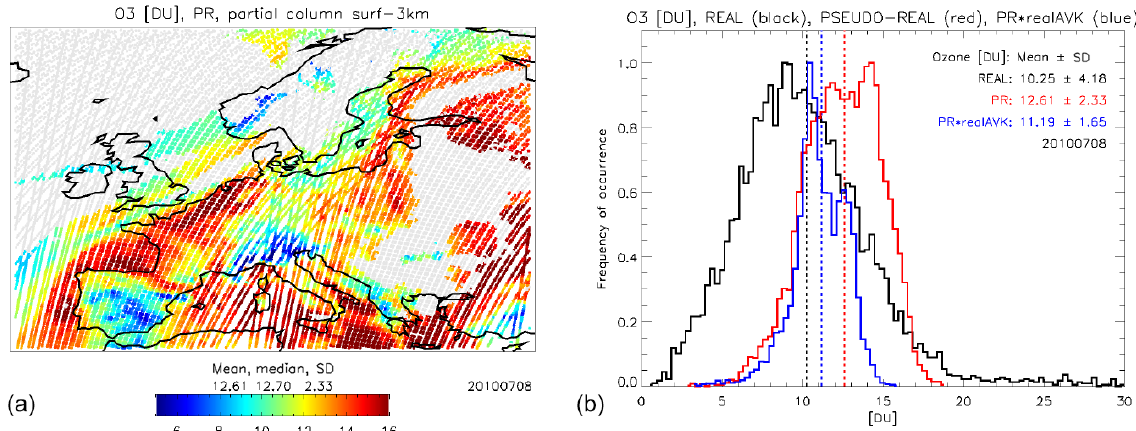
Figure 2. MOCAGE simulation for 8 July 2010. (a) Map of pseudo-real O3-3km [DU]. For consistency with Fig. 1, we consider only those MOCAGE pixels that would have been selected by the IASI + GOME-2 retrieval algorithm on that day. (b) O3-3km [DU] normalized frequency distributions from real IASI + GOME-2 measurements (black), pseudo-real MOCAGE data (red) and PR smoothed by real AVK (blue). Dashed lines show mean O3-3km [DU] values of each